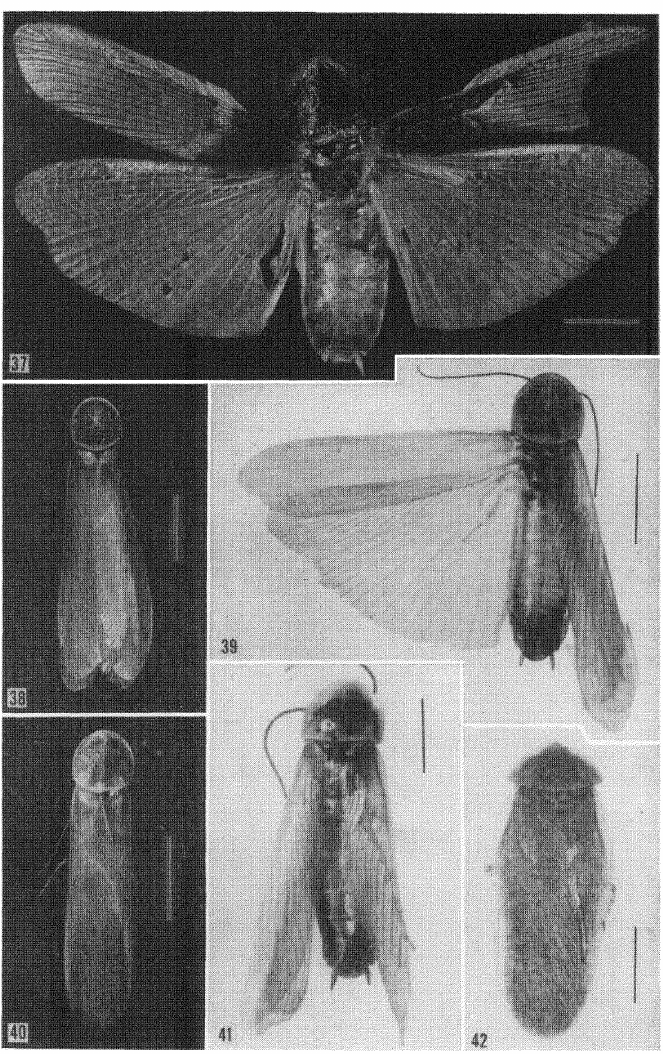
Figures 37-42. Adult males of Cyrtotria, Pilema, and Hostilia spp. 37. (6: BMNH). G. latilennis (holotype of Thysanoblatta la.tiI)ennis Kirby) British East Afriea. 38. (53 BMNH). P. dentata Sauss. and Zehn. Pre- tori.a, South Africa (det. Prineis). 39. (989 L). P. cribrosa (Sauss.). Pretoria, South Africa (det. Prineis). 40. (990 L). P. thoracica (Walker). Mamathes, Basutoland (det. Prineis). 41. (991 L). P. reltexa (Walker). Zululand, Mtubatuba Dist., Dukuduku, South Africa (det. Prineis). 42. (1406 L). H. claeigera (Kirby). Blouberg, Transvaal (det. Prineis). (scale MFigs. 37, 41, 42--5 mm; Figs. 38-40--10